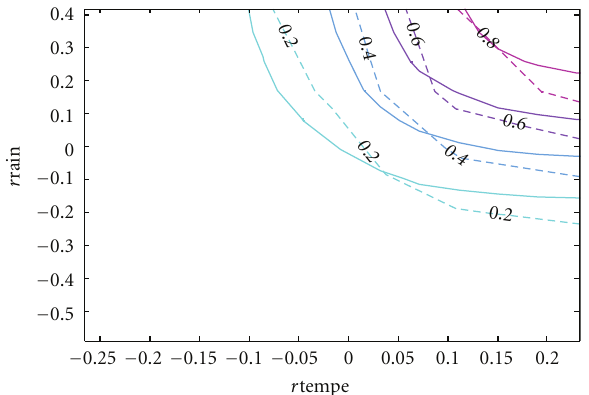
Figure 13: Real versus Gumbel fitted CDF. Note: The dashed lines are the real CDFs while the solid lines are the simulated CDFs.